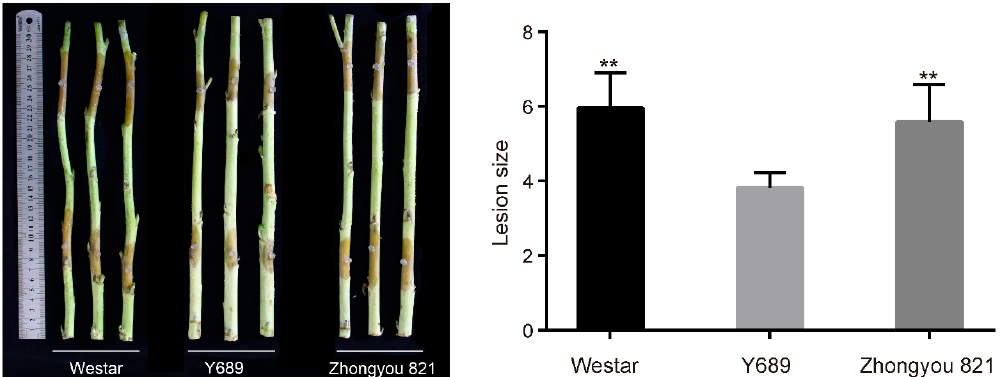
Figure 1. Resistance to Sclerotinia sclerotiorum of the two parents ‘Westar’ and ‘Y689 ′ , and the control line ‘Zhongyou 821 ′ . The level of resistance of ‘Y689 ′ to S. sclerotiorum was significant compared to ‘Westar’ and ‘Zhongyou 821 ′ . ** means the significance level between Y689 and the other two lines, p ≤ 0.01.